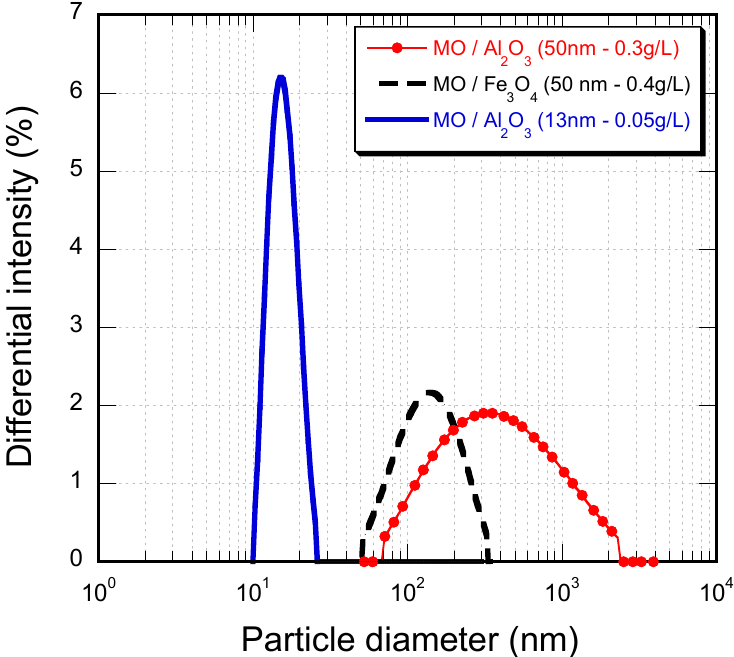
Figure 1. Particles size analysis of nanofluid samples.